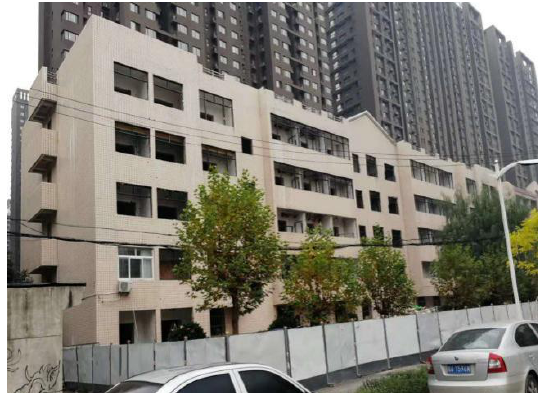
Figure 6. Building appearance.